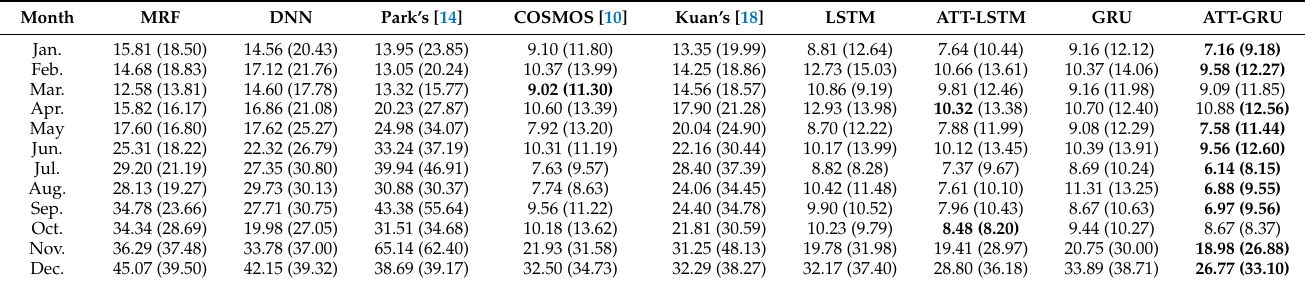
Table 8. MAPE (CVRMSE) comparison by months for Building 2.